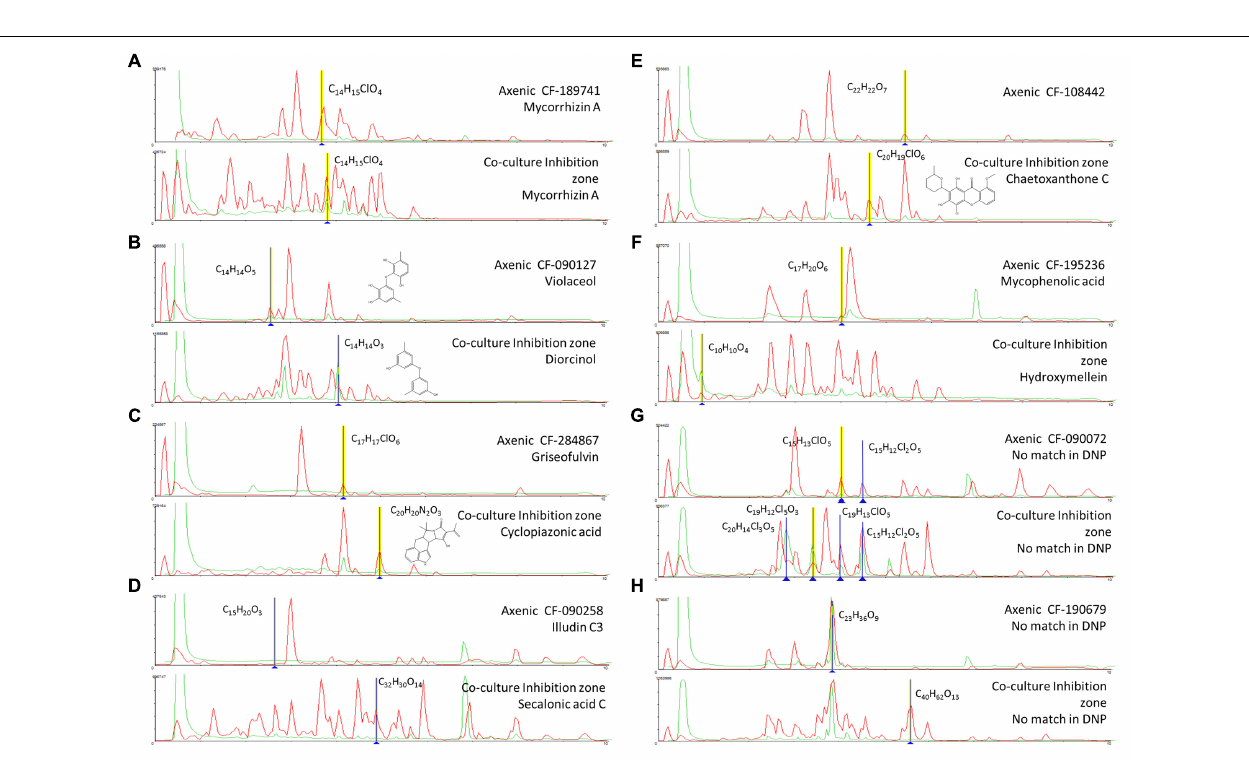
FIGURE 5 | (A-H) Comparison of the secondary metabolite profiles produced by each axenic wild type fungal strains and its co-culturing with B. cinerea . Tentative LCMS identification of the main induced secondary metabolites is highlighted in each case.